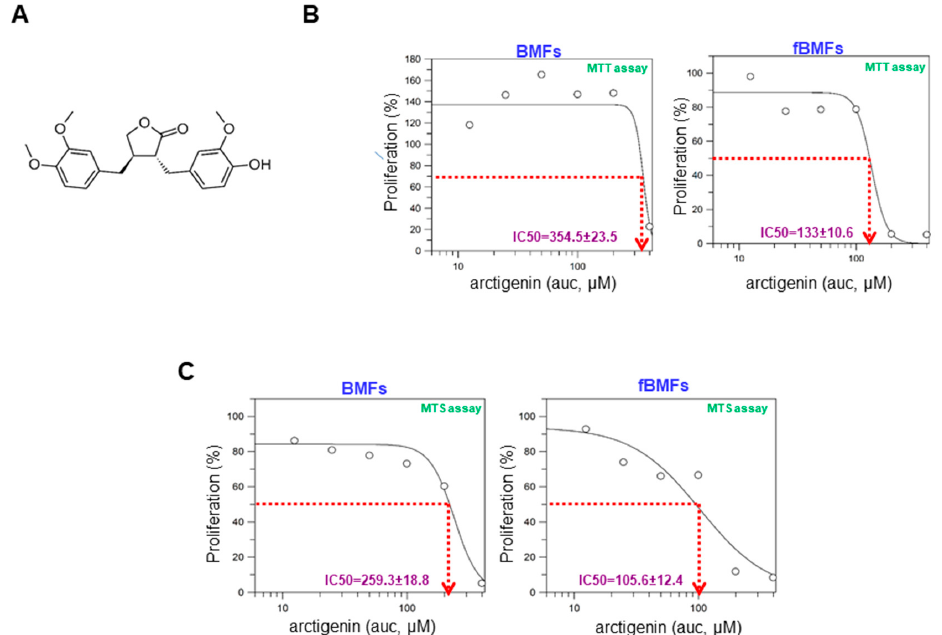
Figure 1. The cytotoxic effect of arctigenin on the viability of buccal mucosal fibroblasts (BMFs) and fibrotic BMFs (fBMFs). ( A ) The chemical structure of arctigenin; ( B ) MTT and ( C ) MTS assays were utilized to examine cell survival/proliferation in response to arctigenin. Normal BMFs and fBMFs were seeded at 1 × 10 4 cells/well and treated with the indicated concentration of arctigenin for 2 days (five replicates for each concentration). The IC50 values were calculated by GraFit software. 2.2. Arctigenin Prevents the Arecoline-Associated Myofibroblastic Transdifferentiation of BMFs